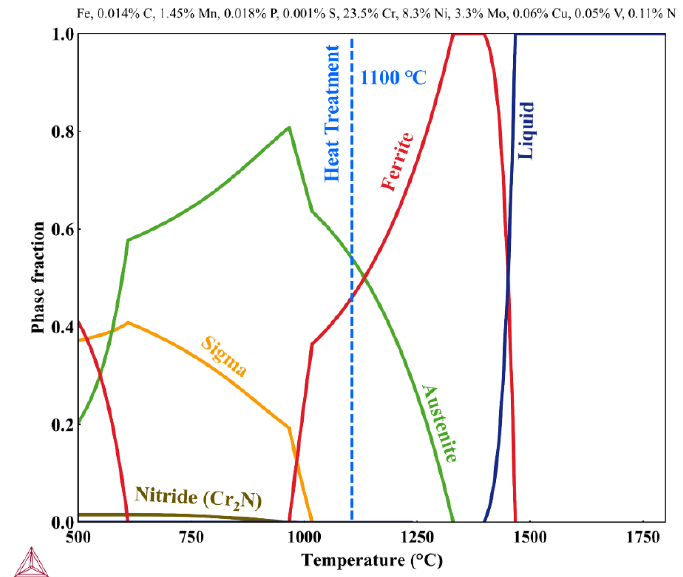
Figure 11. Phase diagram calculated with Thermo-Calc for laser metal deposited DSS components with a nitrogen content of 0.11 wt.%.